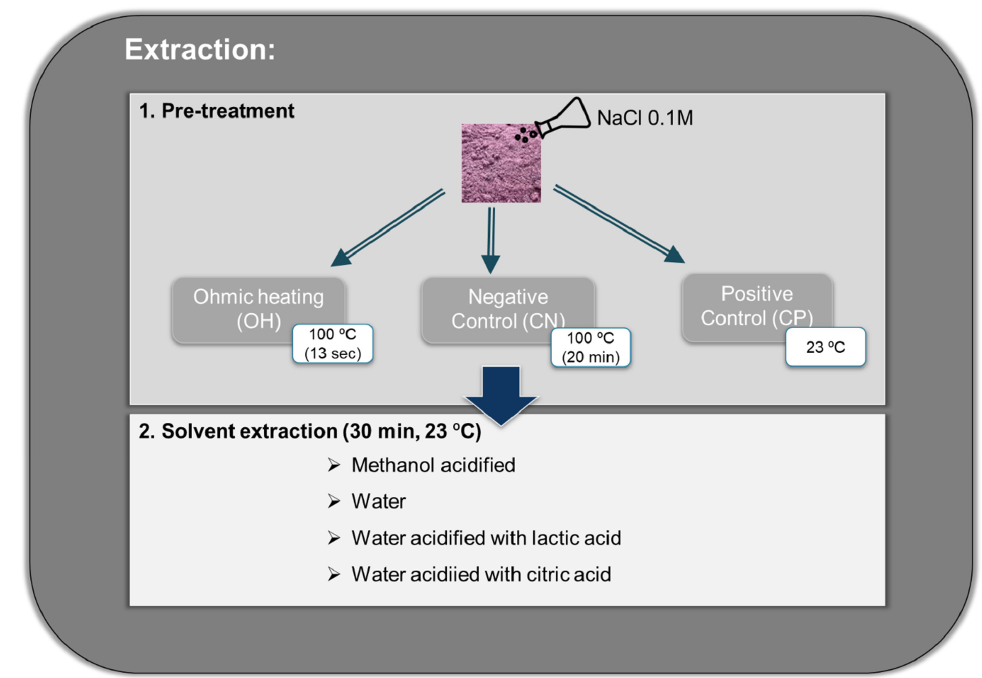
Figure 7. Scheme of experimental analysis.